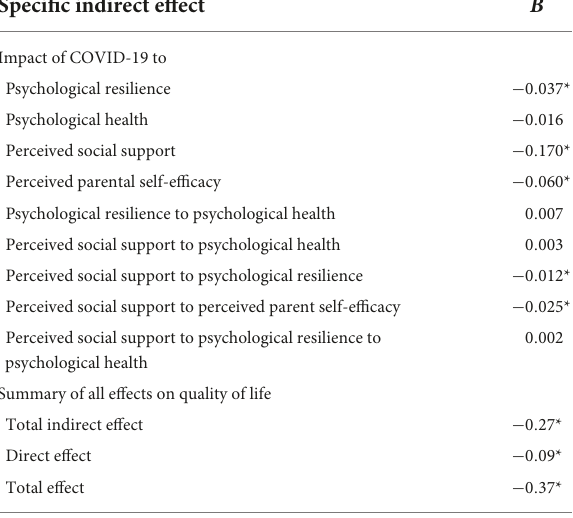
TABLE 5 Specific indirect effects from impact of COVID-19 to family quality of